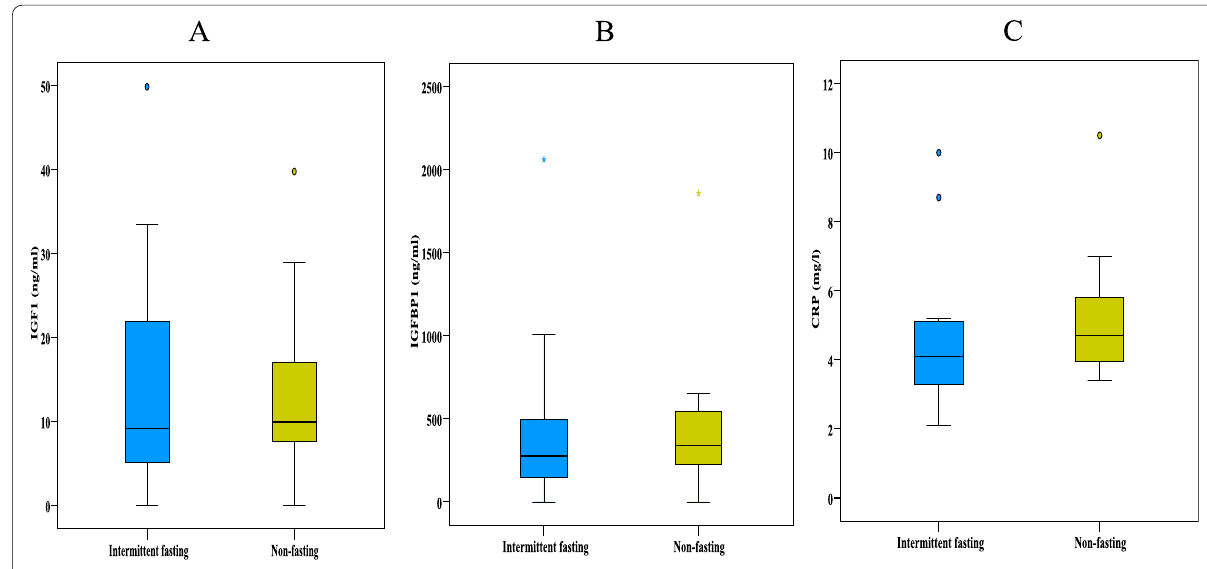
Fig. 3 A comparison between the two studied groups according to IGF1 (ng/ml), IGFBP1 (ng/ml), and CRP (mg/l) after cycle 4. A shows no significant differences in IGF1 between the two studied groups after cycle 4. B shows no significant differences in IGFBP1 between the two studied groups after cycle 4. C shows no significant differences in CRP levels between the two studied groups after cycle 4. Information is displayed by the box‑and‑whisker plot. IGF1, insulin‑like growth factor‑1; IGFBP1, IGF‑binding protein 1; CRP, C‑reactive